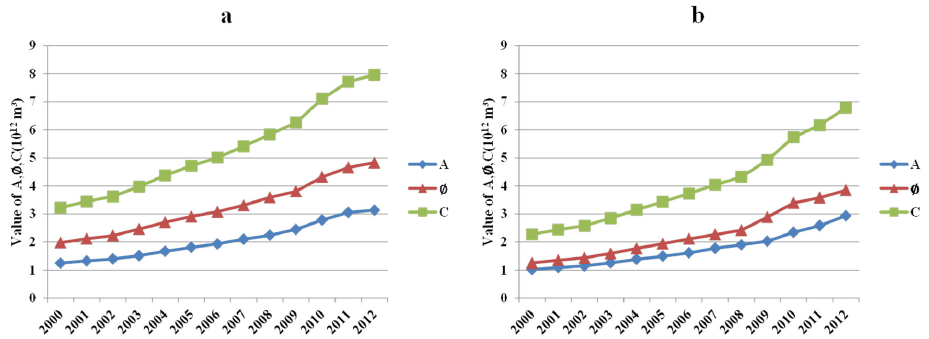
Figure 3. Changes in the security level of China’s natural gas supply system from 2000 to 2012 based on network models: ( a ) The RL and ( b ) The NL.